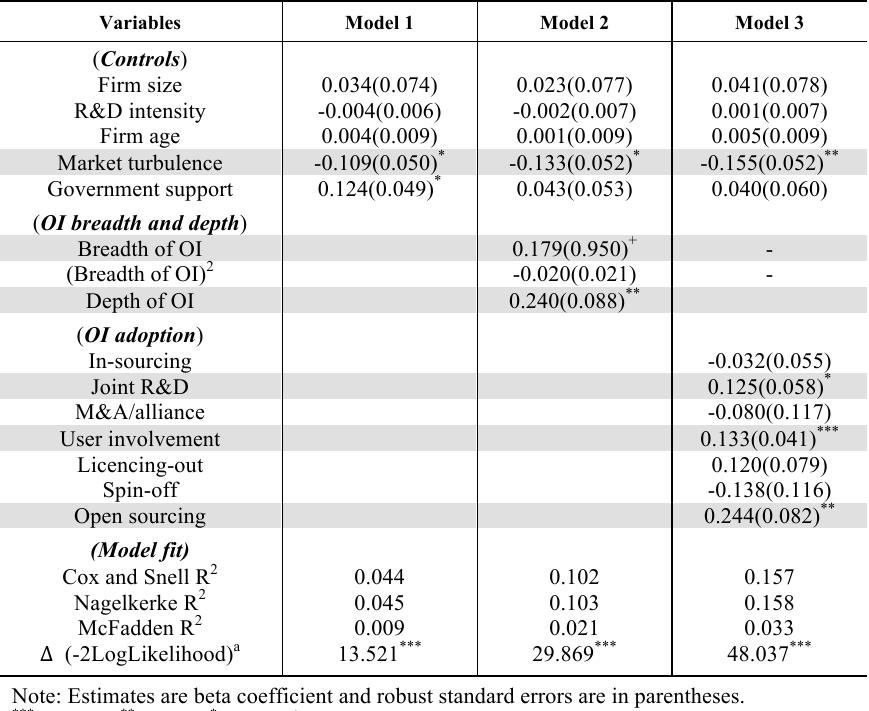
Table 4. OI adoption and firm